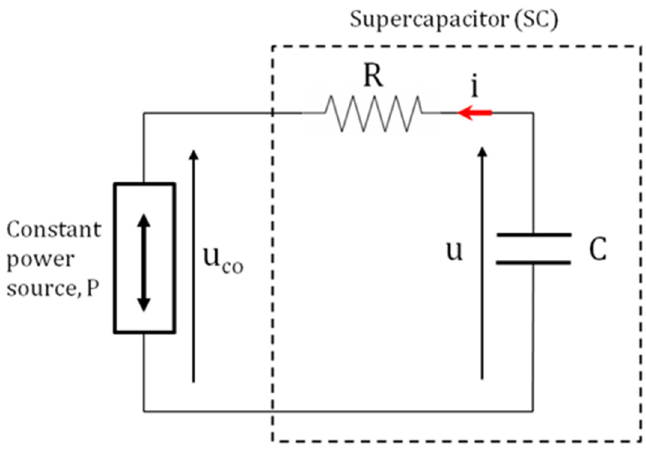
Figure 2. Discharge of an SC at constant power.